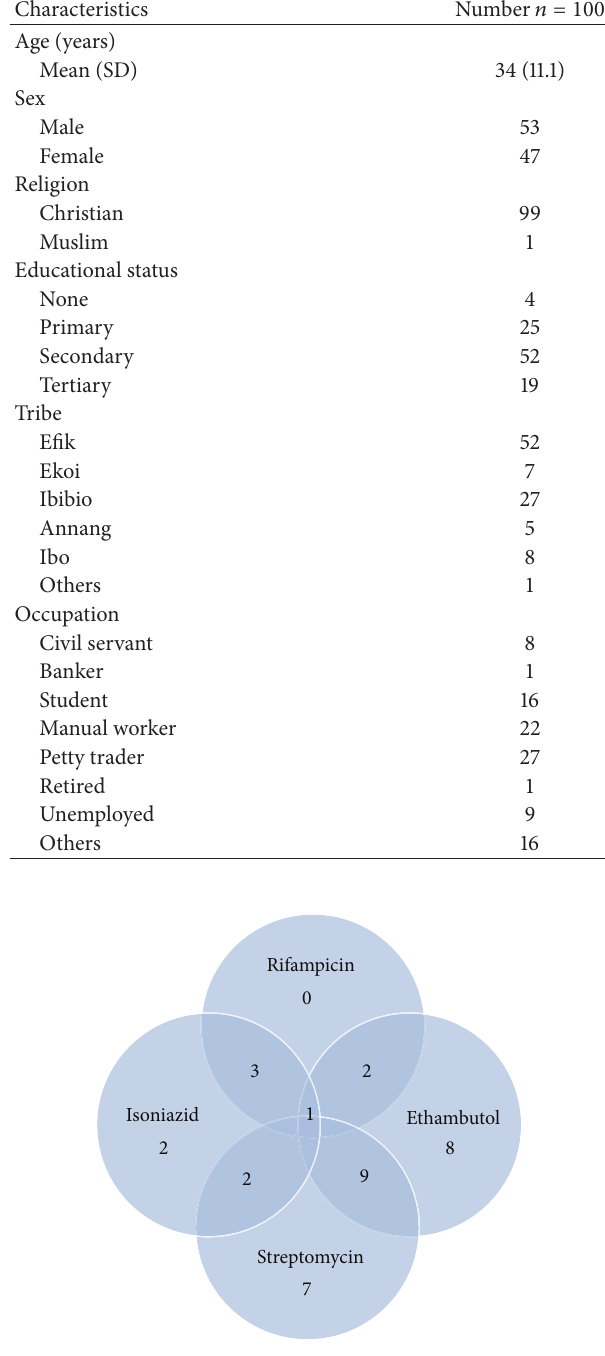
against the dependent variable (resistance to anti-TB